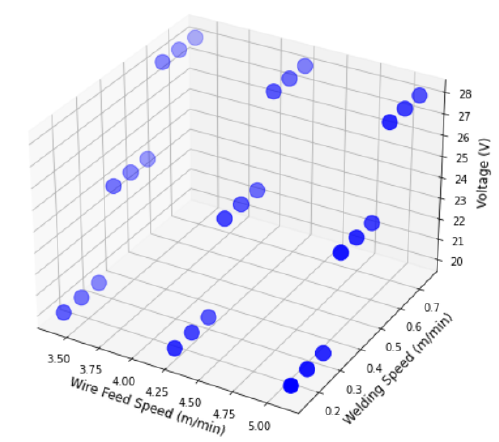
Figure 9. GMA-Welding Parameter Range and Experimental plan.